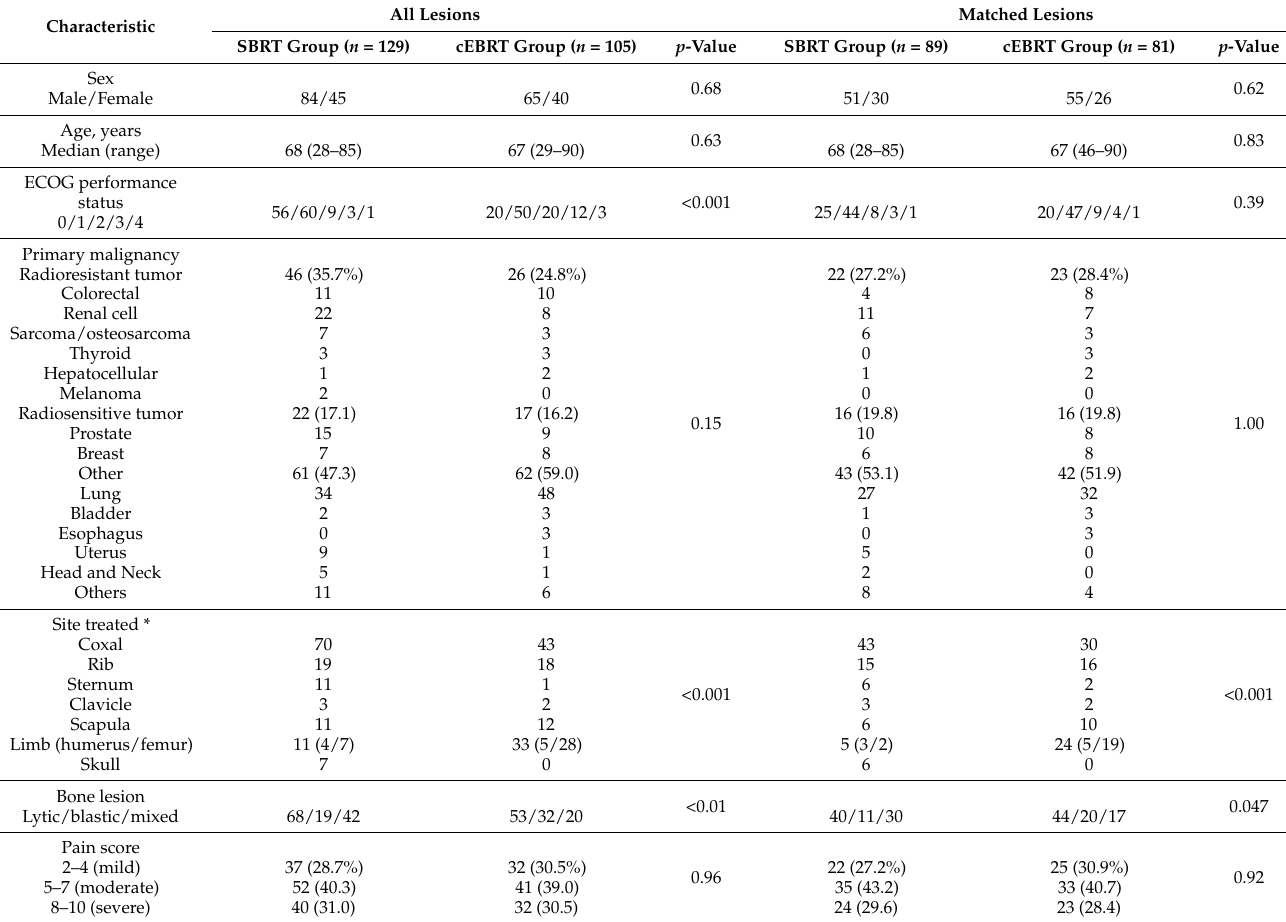
Table 1. Patient and tumor characteristics of all lesions and matched lesions.